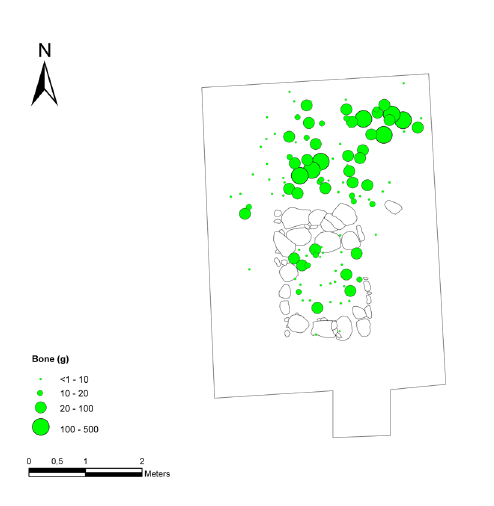
Figure 8. The distribution of bones (weight units) in the H5 area,